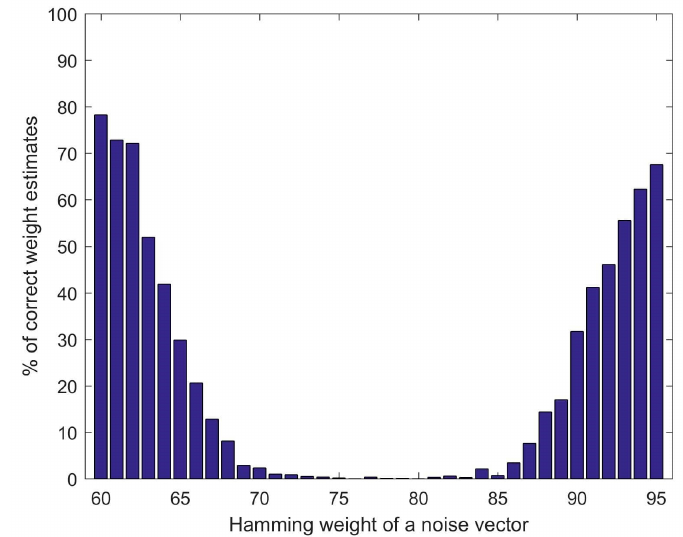
Figure 7. Success rate of the OOV weight estimate algorithm for the noise vectors whose Hamming weight is between 60 and 95. The number of modifications is set to 18,000.